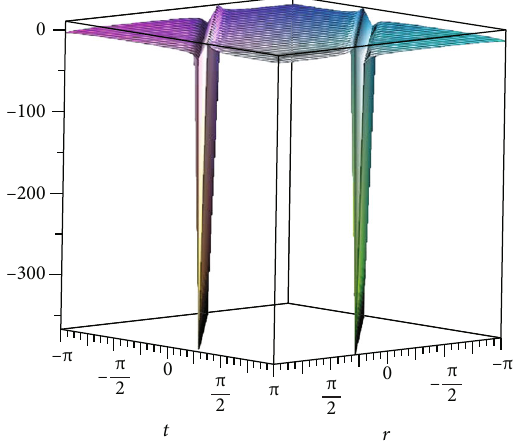
ð (cid:1) r , t Þ , for (cid:1) r , t = − π :: π , s 2